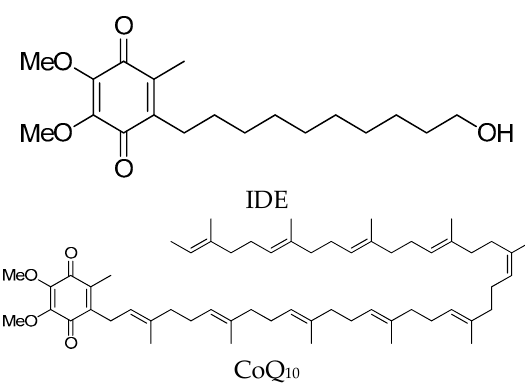
Figure 1. Chemical structures of IDE and CoQ 10 .